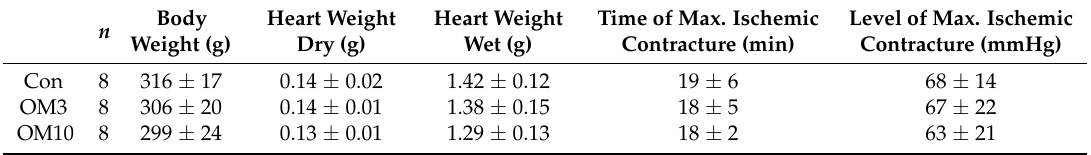
Table 2. Weights and ischemic contracture.